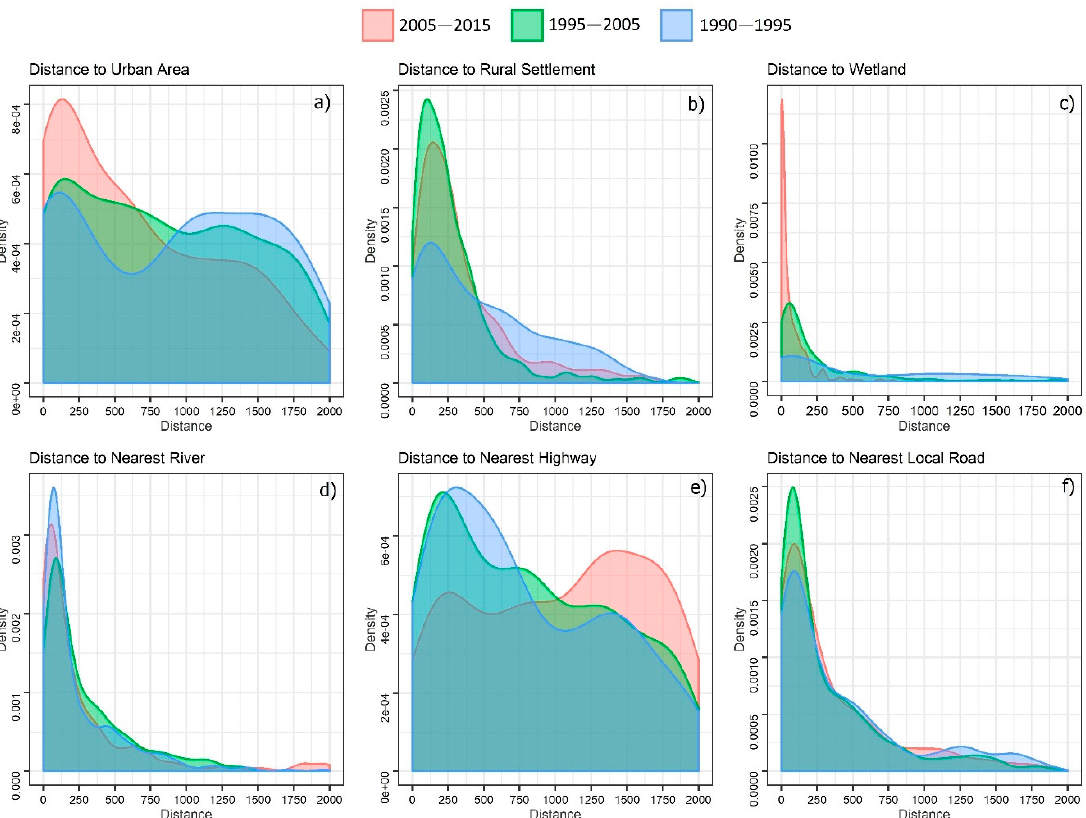
Figure 8. Nearest neighbor distances between newly set up brickfields and urban areas ( a ), rural settlements ( b ), wetlands ( c ), rivers ( d ), highways ( e ) and local roads ( f ), plotted as density functions. Distance on the horizontal axes is indicated in meters, and vertical axes represent bandwidth along with the peak of a density where values are concentrated over the interval.